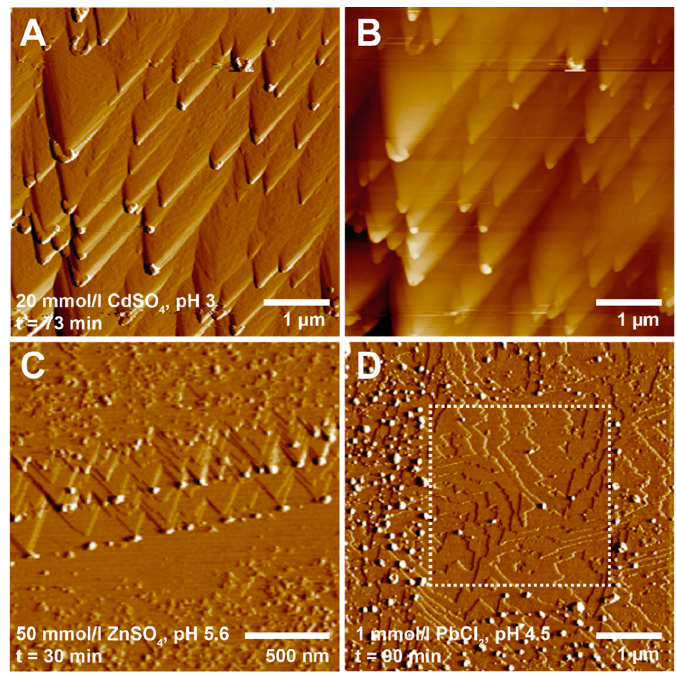
Figure 2. In situ AFM images showing the nucleation of precipitates on brucite surfaces. ( A ) Deflection and ( B ) height image (acquired in liquid) showing the nucleation of nanometer size particles at kink sites on a brucite surface after 73 min in a 20 mmol/L CdSO 4 (pH 3) solution. ( C ) Deflection image (acquired in liquid) of a brucite surface after 30 min in a 50 mmol/L ZnSO 4 (pH 5.6) solution. The image reveals two generations of particles that nucleated at kink sites along a retreating step edge. ( D ) Deflection image (acquired in liquid) showing the covering of a brucite surface with precipitates after 90 min in a 1 mmol/L PbCl 2 (pH 4.5) solution. The central area (outlined by a dashed square) corresponds to an area that was scanned before. This area contains far less particles than the surroundings, showing that the particles were initially weakly attached to the brucite surface, as they could be removed by the AFM tip during